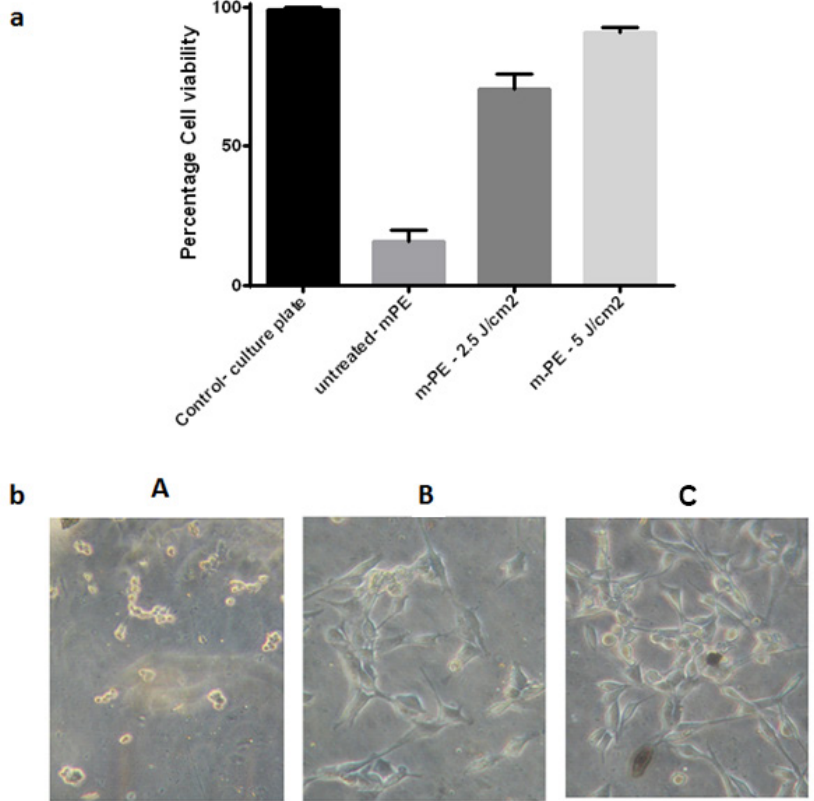
Figure 4 - ( a ) Cell viability of mPE, mPE-2.5 J/cm 2 and mPE-5 J/cm 2 treated samples after 24 h using MTT assay ( b ) Photomicrograph of the mPE, mPE-2.5 J/cm 2 and mPE-5 J/cm 2 treated samples seeded with 3T3 fibroblast cells after 24 h. The mean of the mPE and mPE- 2.5 J/cm 2 and mPE-5 J/cm 2 treated samples along with their standard deviation is indicated from three individual